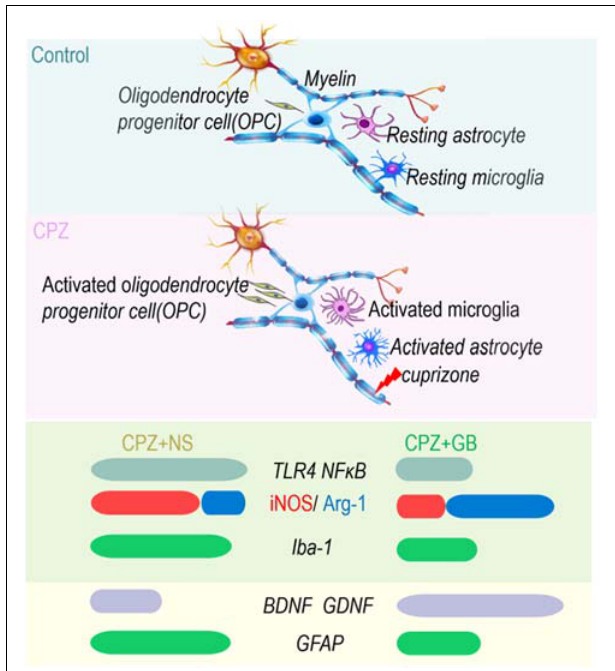
FIGURE 11 | GB enhanced spontaneous remyelination by regulating the dynamic balance of microglia and astrocytes. On the one hand, GB inhibits inflammatory signals (TLR4 and NF- κ B) and induces the M2 phenotype of microglia (iNOS ↓ and Arg-1 ↑ ); on the other hand, GB promotes astrocytes to produce BDNF and